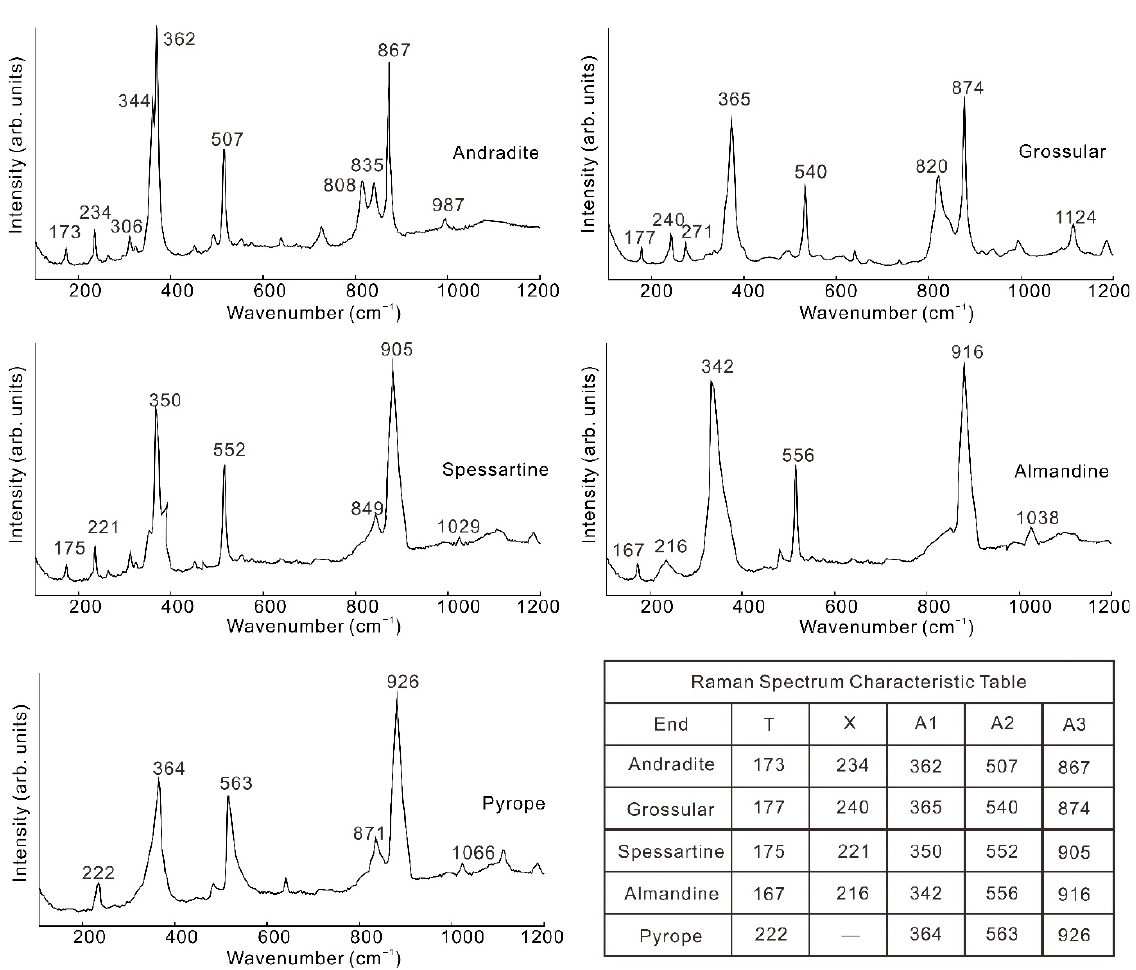
Figure 4. Raman spectra of end member garnet (modified according to [14,19,34]).